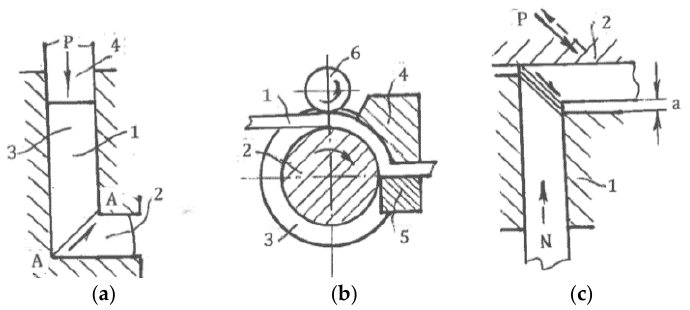
Figure 15. Simple shear SPD: ( a ) Equal-channel angular extrusion/pressing (ECAE/ECAP); ( b ) Continuous ECAE-conform; ( c ) Semi-continuous incremental—ECAP. ECAE-conform; ( c ) Semi-continuous